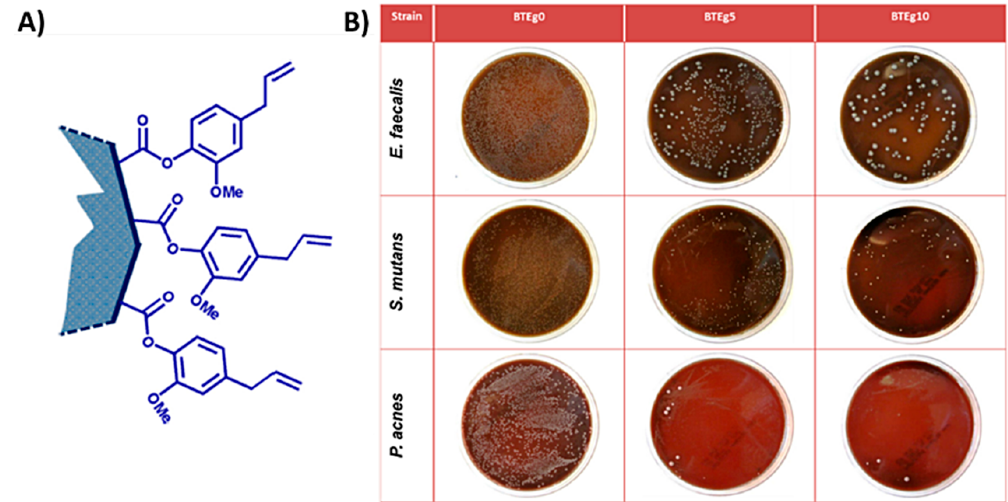
Figure 5. Schematic illustration of pendent eugenyl residues from the polymeric network on the surface of the composites ( A ), and images of composites surface antibacterial activity assay according to the ISO 22196:2007 after 24 h of incubation ( B ). Adapted from Almaroof et al. 2016 [105], with permission from Elsevier.